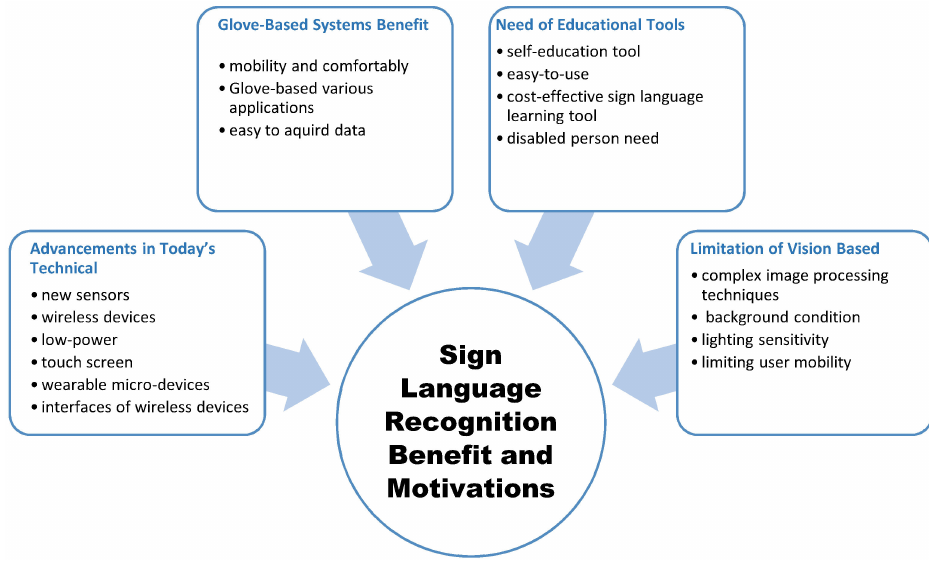
Figure 27. Categories of benefits of SLR based on the sensor